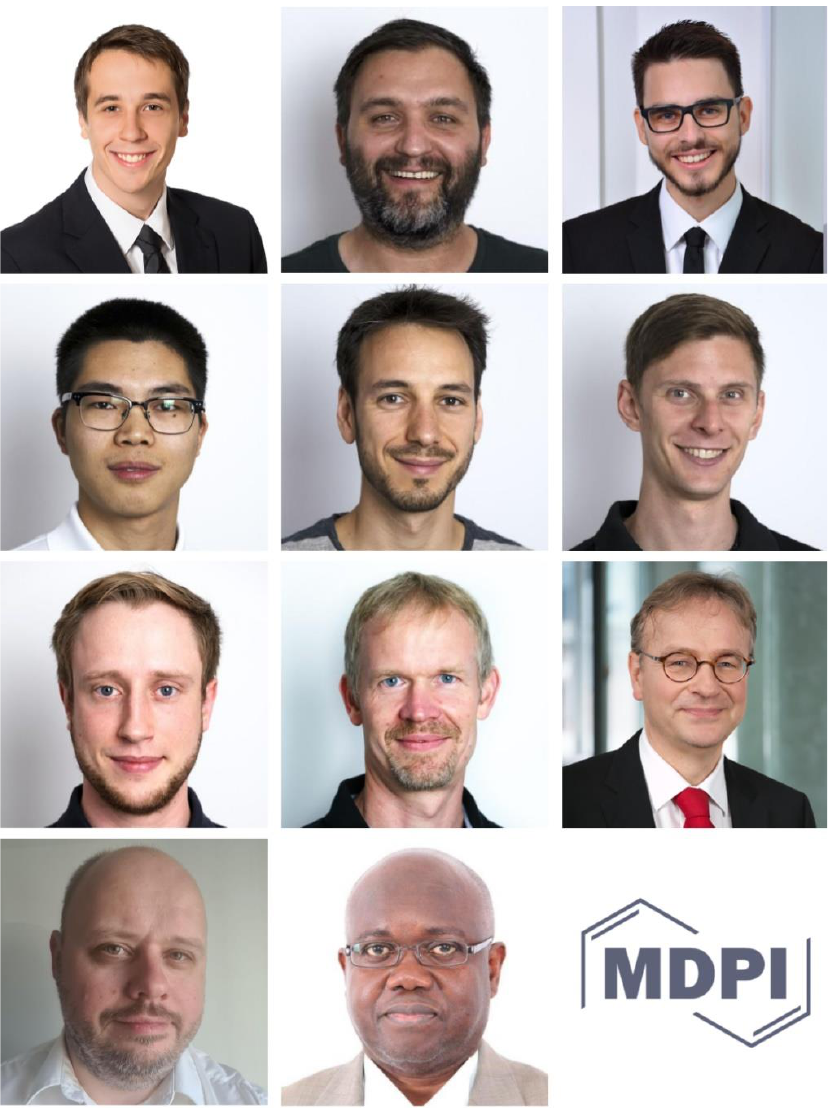
Figure 2. Marc Haussmann, Florian Ries, Jonathan B. Jeppener-Haltenhoff, Yongxiang Li, Marius Schmidt, Cooper Welch, Lars Illmann, Benjamin Böhm, Hermann Nirschl, Mathias J. Krause, and Amsini Sadiki (from left to right and from up to down). and Amsini Sadiki (from left to right and from up to